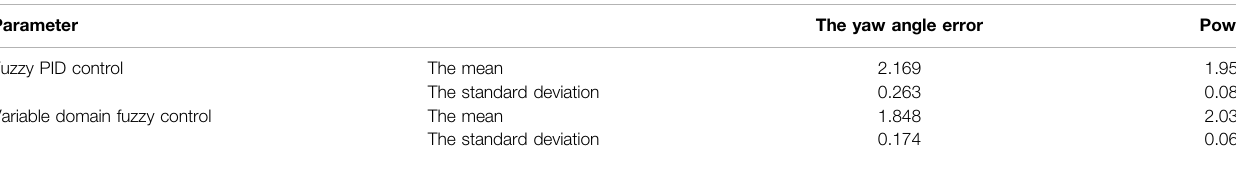
TABLE 5 | Yaw system experiment compared